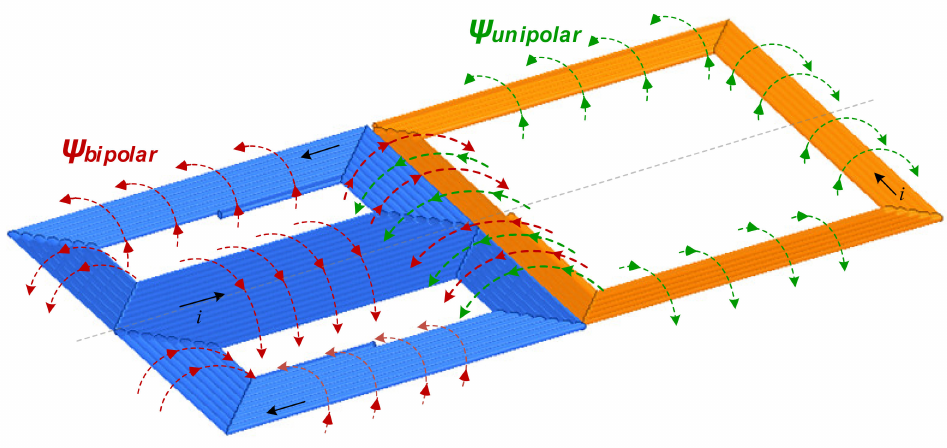
Figure 1. Flux diagram of the Q-shaped coil and the DD coil.